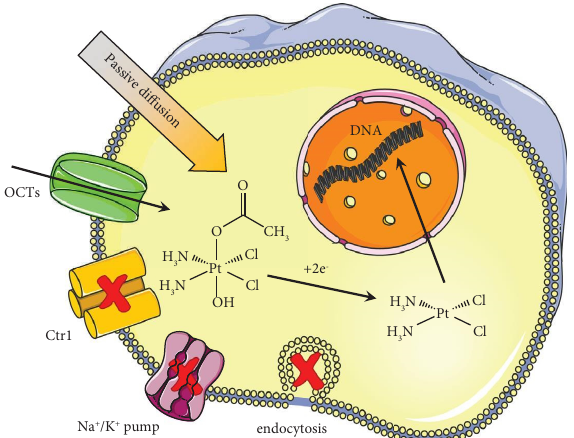
Figure 10: A tentative scheme of the suggested mechanism of internalization of compound 2